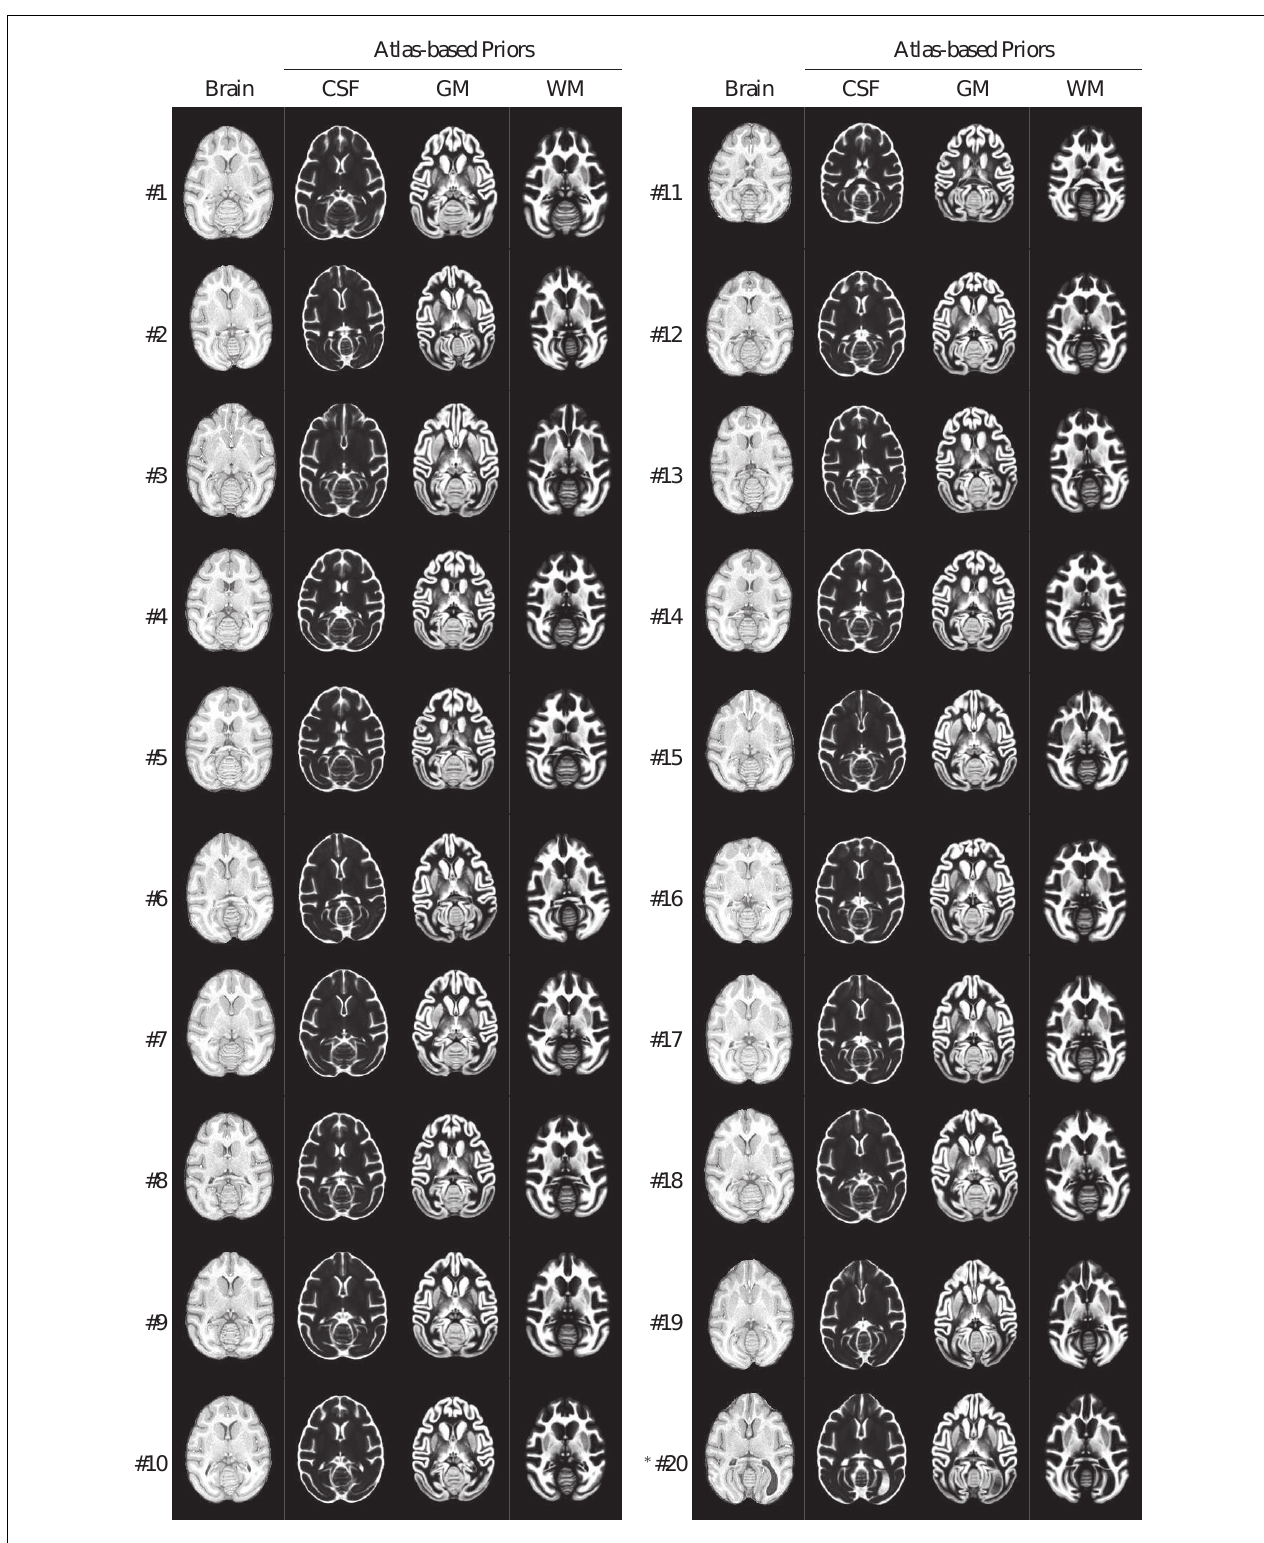
FIGURE 9 | INIA19 tissue priors reformatted to each of 20 animal images via non-rigid registration. *Animal #20 was the one that was excluded from atlas generation due to abnormal ventricular anatomy, which is clearly visible in the posterior right (animal-left) hemisphere.